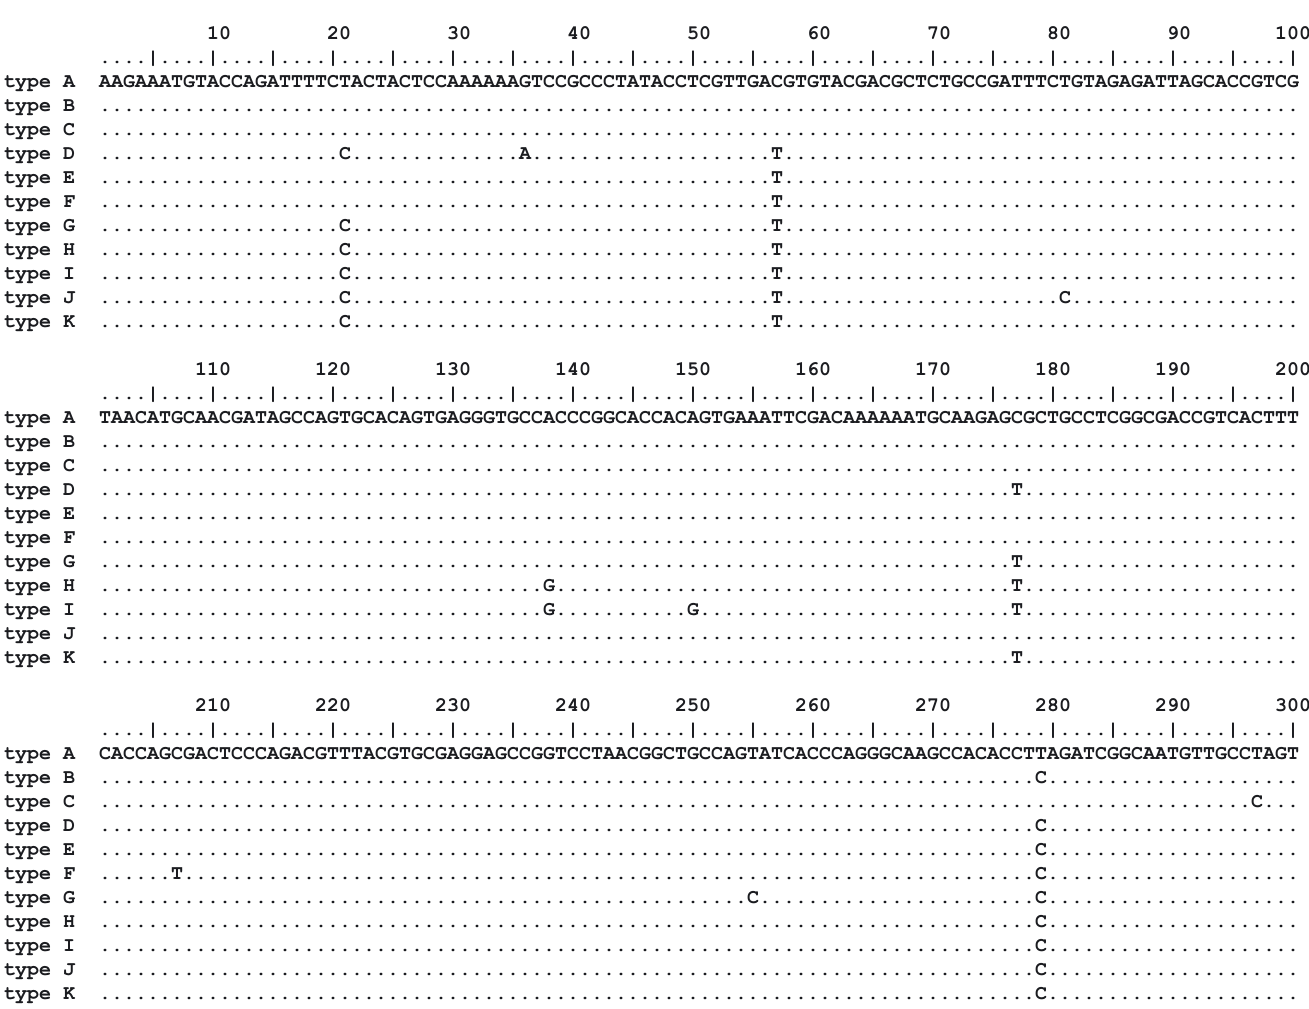
Fig. 2. Nucleic acid variability (type A to K) observed in the partial E2 gene of salmonid alphavirus Subtype V originating from common dab Limanda limanda observed in the present study. Numbers are base